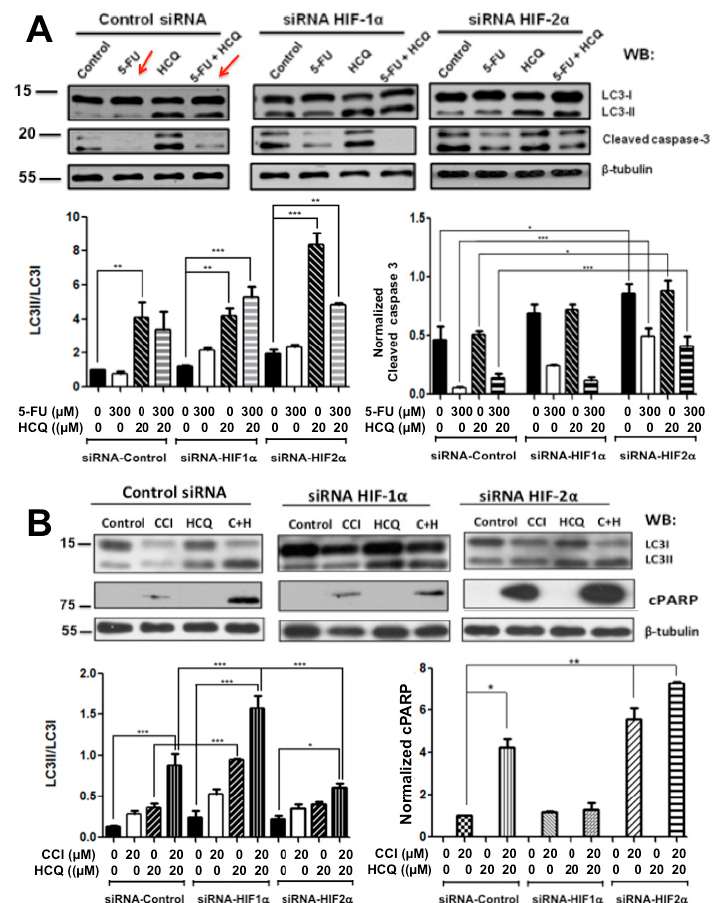
Figure 4. Comparative analysis of the e ff ect of HIFs silencing on cell death induced by drug treatment produced in sensitive vs. resistant SW480 colon cancer cells. ( A ) Resistance against 5-Fluoruracil (5-FU) can be reversed by HIF-2 α silencing. Control or HIF-silenced SW480 cells, which are resistant to 5-FU, were treated with 300 µ M 5-FU alone, with 20 µ M HCQ, or in combination with both agents for 48 h. Cell extracts were analyzed by Western blotting to detect autophagy levels and apoptosis. β -tubulin was used to control for equal loading. ( B ) Control or HIF-silenced SW480 cells, which are sensitive to the mTORC1 inhibitor CCI-779, were treated with 20 µ M CCI-779 alone, with 20 µ M HCQ, or in combination with both agents for 48 h. Cell extracts were analyzed by Western blotting to detect autophagy levels and apoptosis. β -tubulin was used as a control for equal loading. The results shown in both panels are representative of at least three independent experiments using di ff erent cell preparations. Densitometric analysis was performed in each panel to estimate the changes in LC3II / I ratio and in cleaved Caspase 3 levels compared to the levels found in control HIFs- expressing cells. Data represent the means ± SEM of at least three independent experiments. * p < 0.05; ** p < 0.01; *** p <